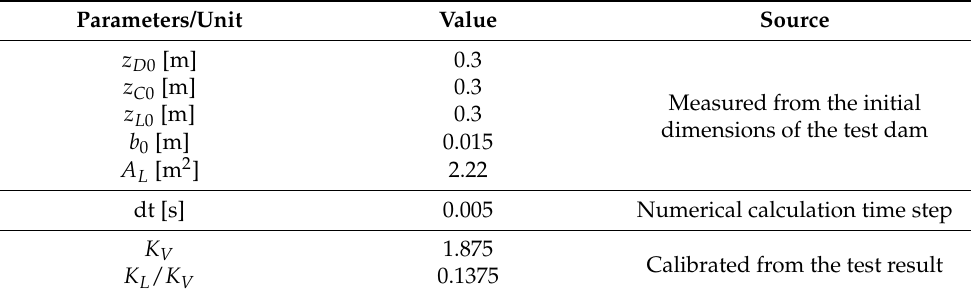
Table 4. Parameters for the proposed dam breach model for the test dam. Parameters/Unit Value Source z D 0 [m] 0.3